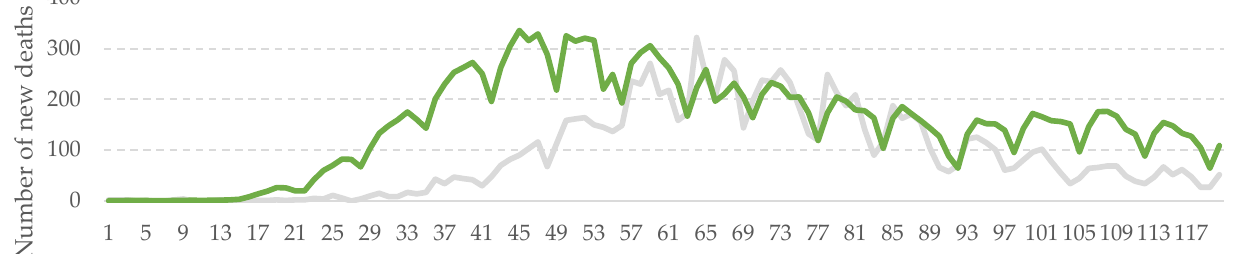
Figure 7. Prediction of robust design-based expert system. (January 2022–April 2022, in Japan). It can be easily discovered from Table 5 that these features are mainly descriptive variables and demographic variables relating to COVID-19. As to the features associated with CVD death rate and diabetes prevalence, no significant difference was found between different epidemic levels. The gray line shows the actual data, while the green one represents the epidemic trend predicted by the proposed system (see Figure 7). The results indicate that the mean number of daily death cases of the proposed system was 151 persons with a standard deviation of 94 persons in this span of prediction. In the actual data, the mean number of daily death cases was 89 persons with a standard deviation of 84 persons. The time point of the increase in the death rate estimated by this system is slightly earlier than the actual data. Overall, it is quite close to the actual situation. A further comparison of the system’s prediction with the actual data was conducted. Table 5. Selected and unselected informative features of COVID-19 in Japan.